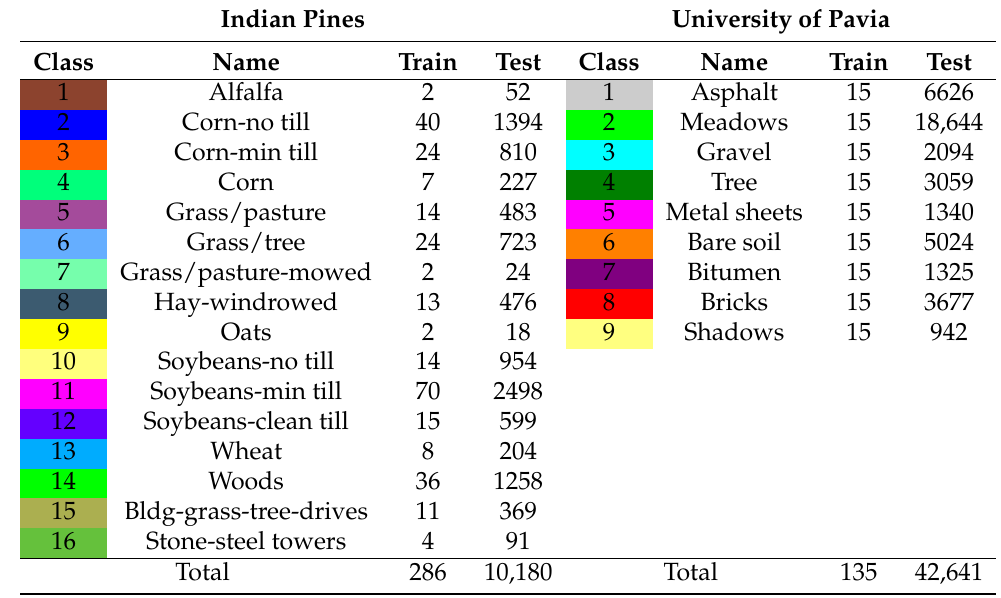
Table 1. Details of the training samples and test samples for the two datasets used for the evaluations (the background color represents the label of one